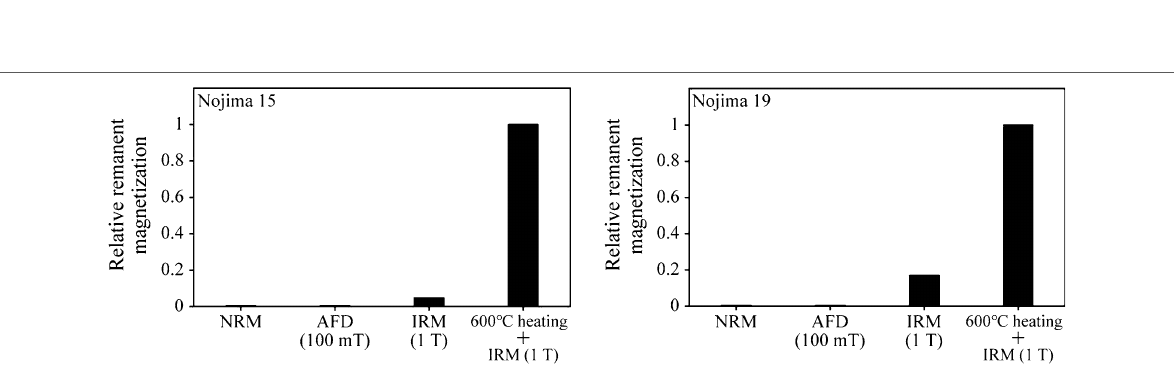
Fig. 5 Relative remanence magnetization of two fragment gouge samples under natural remanent magnetization (NRM), alternating field demagnetization (AFD) at 100 mT, isothermal remanent magnetization (IRM) at 1 T and IRM at 1 T after heating at 600 °C. The raw data are shown